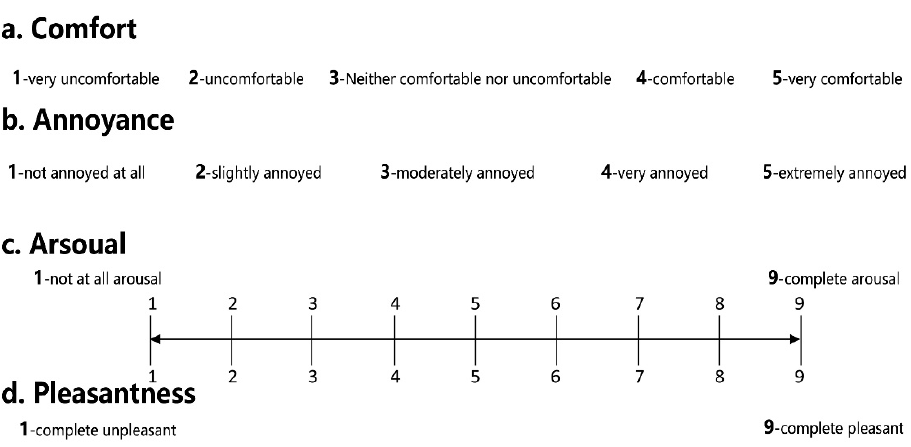
Figure A1. Questionnaire used in the experiment.